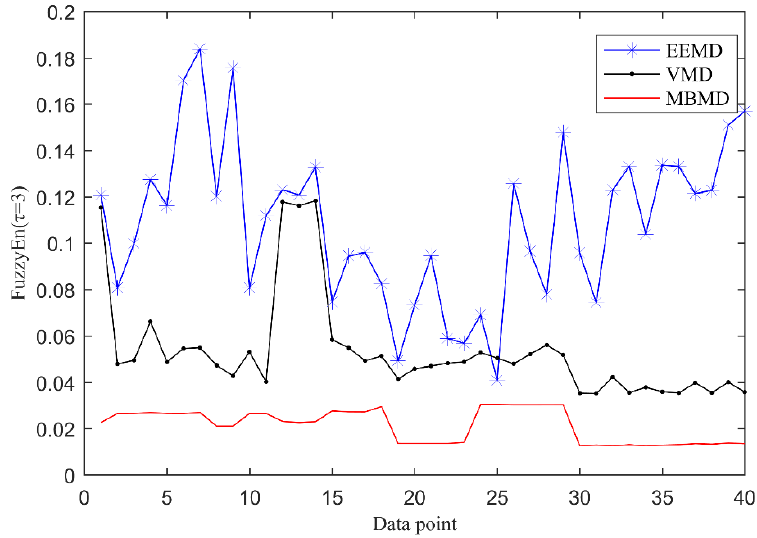
Figure 26. MBMD, VMD, EEMD comparison diagram of the harmonic signal plus the narrowband signal.